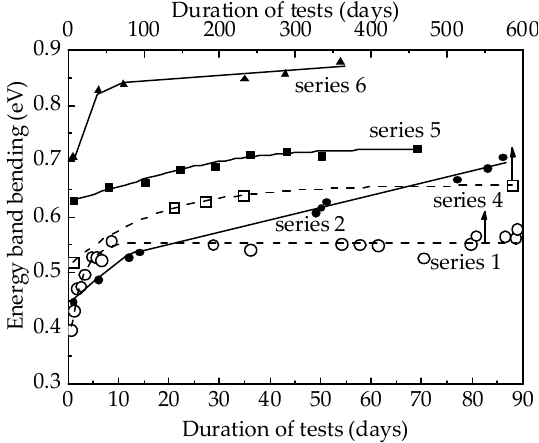
Figure 13. Dependencies of the energy band bending e φ s on the duration of the tests for the sensors of series 1, 2, 4, 5, 6.